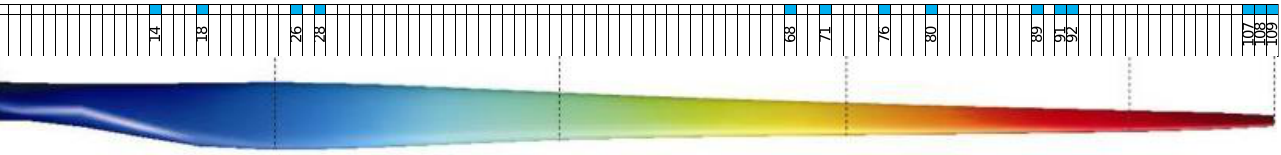
Table 6. The summarized properties of the wind turbine blade (International System—SI). Parameter